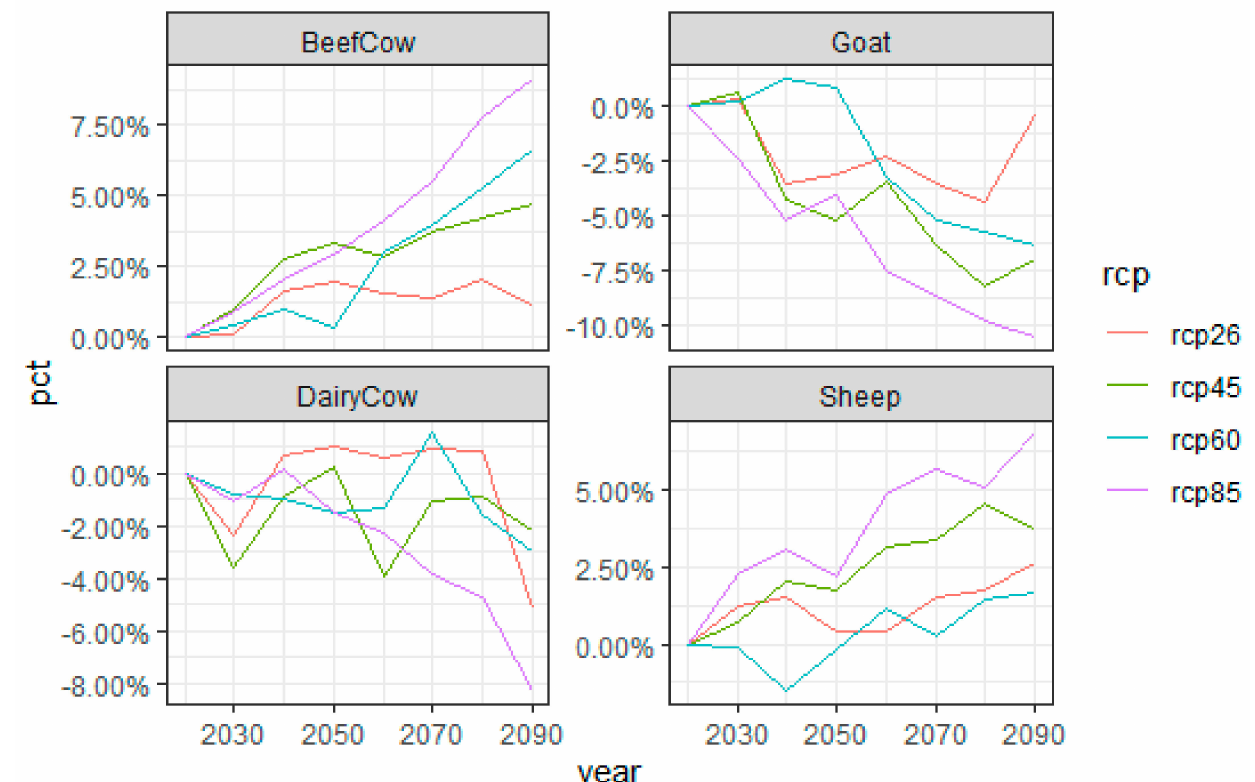
Land 2021 , 10 , x FOR PEER REVIEW 15 of 20